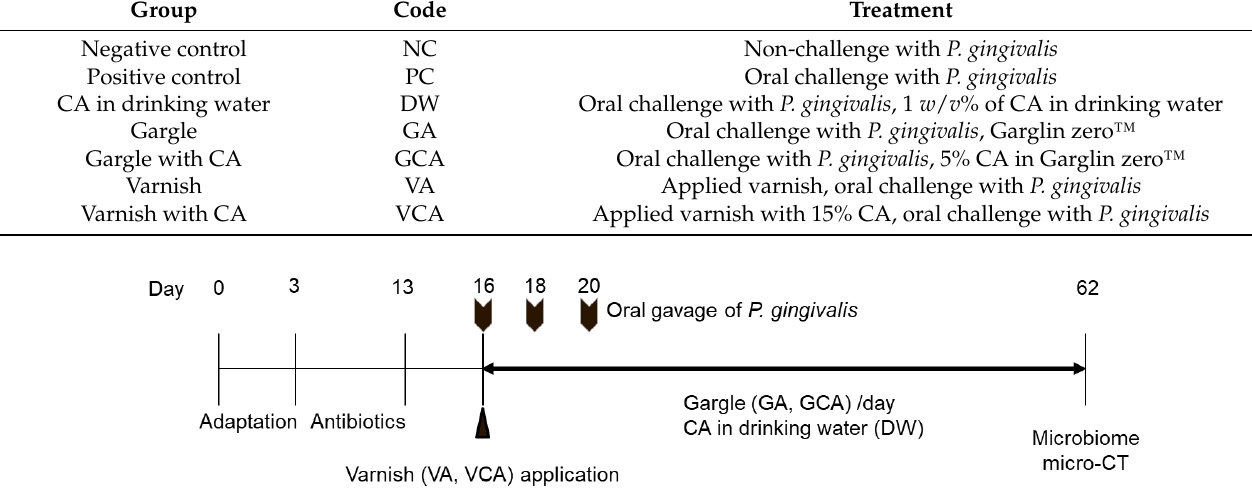
Figure 1. Experimental design of the mouse model according to time frame. After 3 days of adaptation, antibiotics were administered for 10 days followed by 3 days of antibiotic-free period. After oral gavage of P. gingivalis 3 times every 2 days, mice were treated according to group and sacrificed 42 days after the last inoculation of P. gingivalis . GA means gargle group: GCA, gargle containing Colocasia antiquorum var. esculenta (CA) group; VA, varnish application group; VCA, varnish with CA application group.